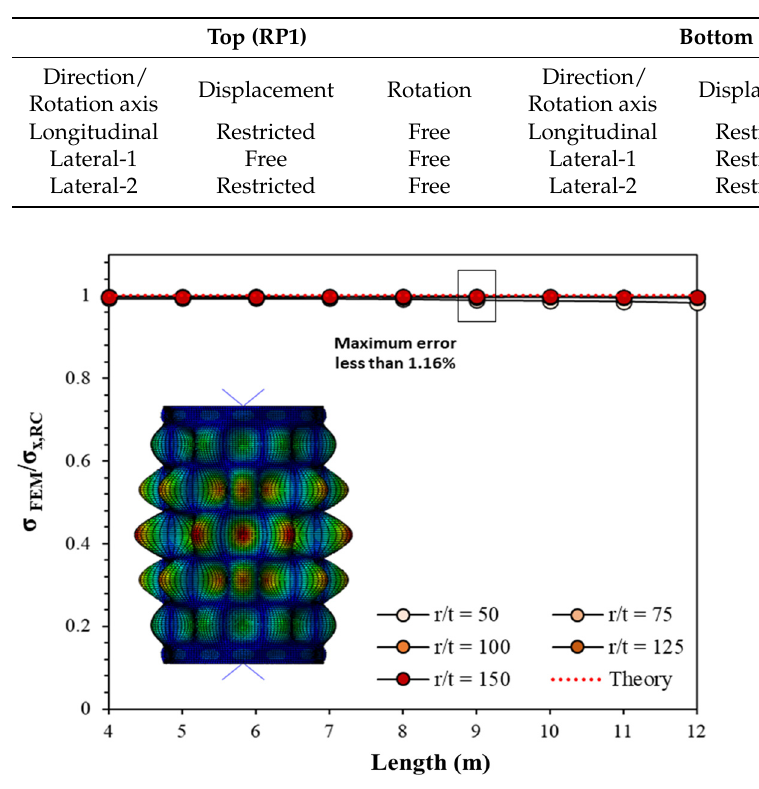
Figure 6. Comparison of eigenvalue results and theoretical strength (1st order mode).